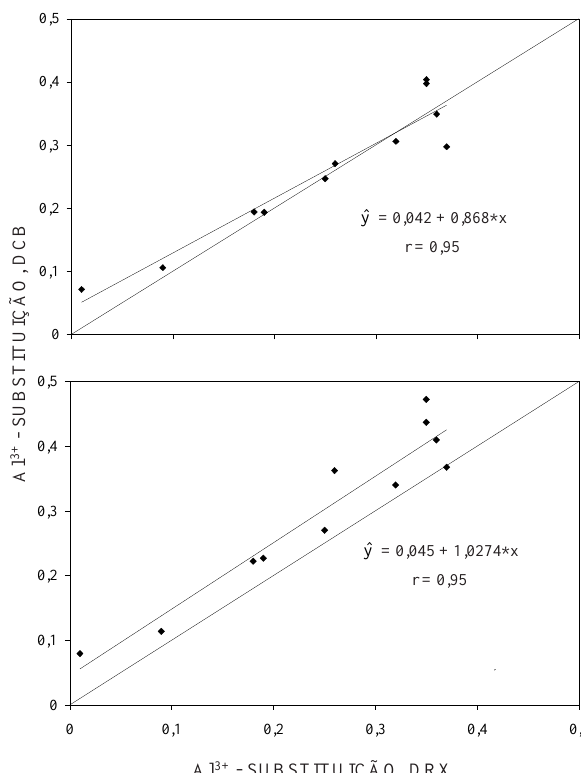
Figura 3. Correlação entre os valores da substituição de Fe 3+ por Al 3+ em mol mol -1 estimados quimicamente, considerando os teores de Al- -1 (a) e de Al-DCB - ∑∑∑∑∑ 4 (b), e os valores DCB 80 80 de Al 3+ em mol mol -1 estimados por DRX, nas amostras goethíticas. * Significativo a 1